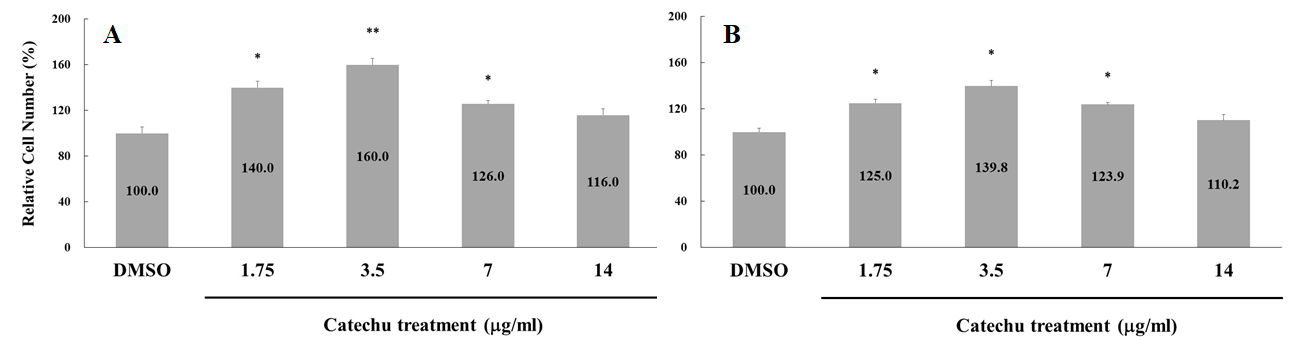
Figure 6. Effects of catechu extracts on ( A ) WS1 and ( B ) HaCaT proliferation. Increased cell proliferation was observed after treatment with catechu extracts for 24 h. Data are presented as means ± SD in three independent experiments. The p -value was calculated versus the control. Using the one-tailed test analysis, * indicates p < 0.05 and ** indicates p < 0.005 between different catechu concentrations.